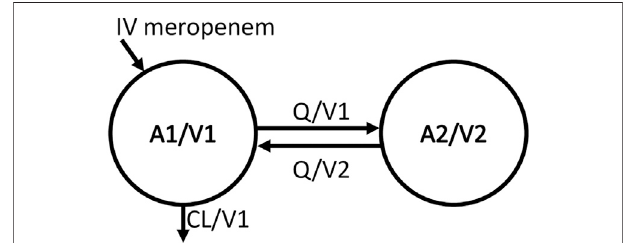
FIGURE2| Structuralmodelschema.Meropenemamountinthecentral compartment (A1), central volume of distribution (V1), intercompartmental clearance (Q), meropenem amount in the peripheral compartment (A2), peripheral volume of distribution (V2), total plasma clearance (CL), meropenem concentration in the central compartment (A1/V1), meropenem concentration in the peripheral compartment (A2/V2), elimination rate constant is CL/V1, transfer rate constant from central to peripheral compartment (Q/V1), and transfer rate constant from peripheral to central compartment (Q/V2).